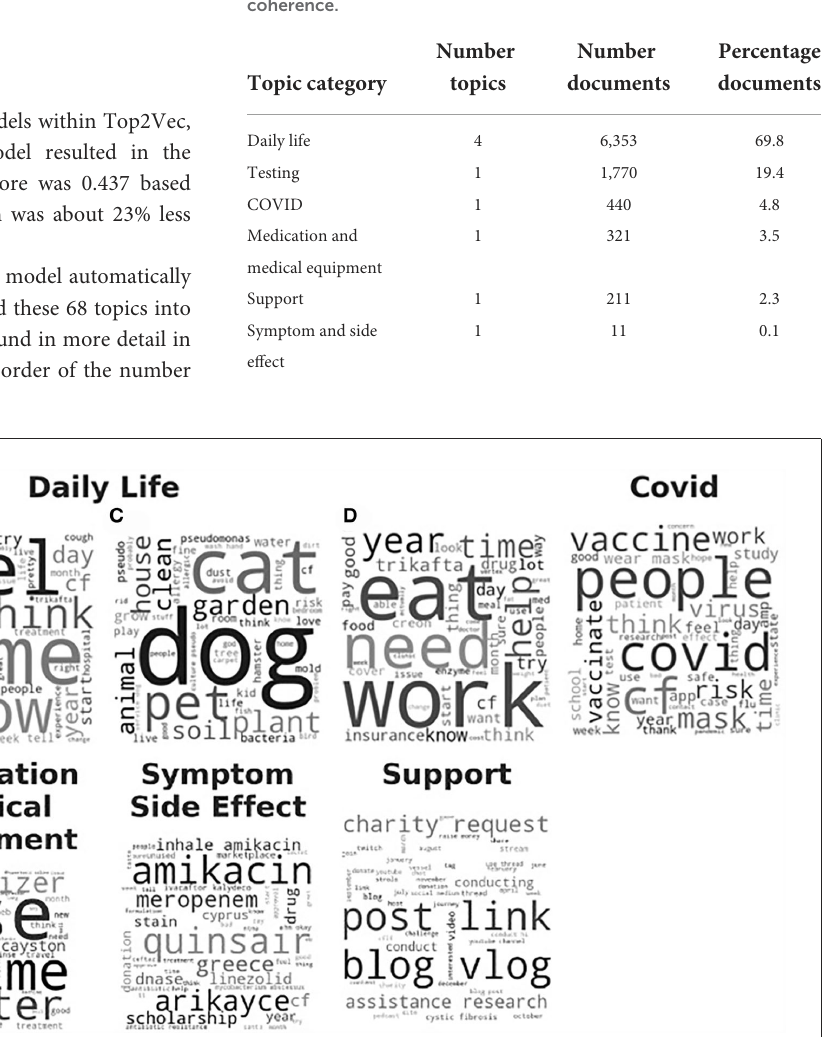
FIGURE3 Word clouds for the 9 topics derived from the Latent Dirichlet Allocation (LDA) model with the highest coherence are sorted by category of interpreted topics. The font size of each word is relative to the probability of that word belonging to a document in that derived topic. Daily Life category consists of 4 subtopics: (A) Recreational drugs and alcohol use, (B) feeling, (C) pets, and (D) work and